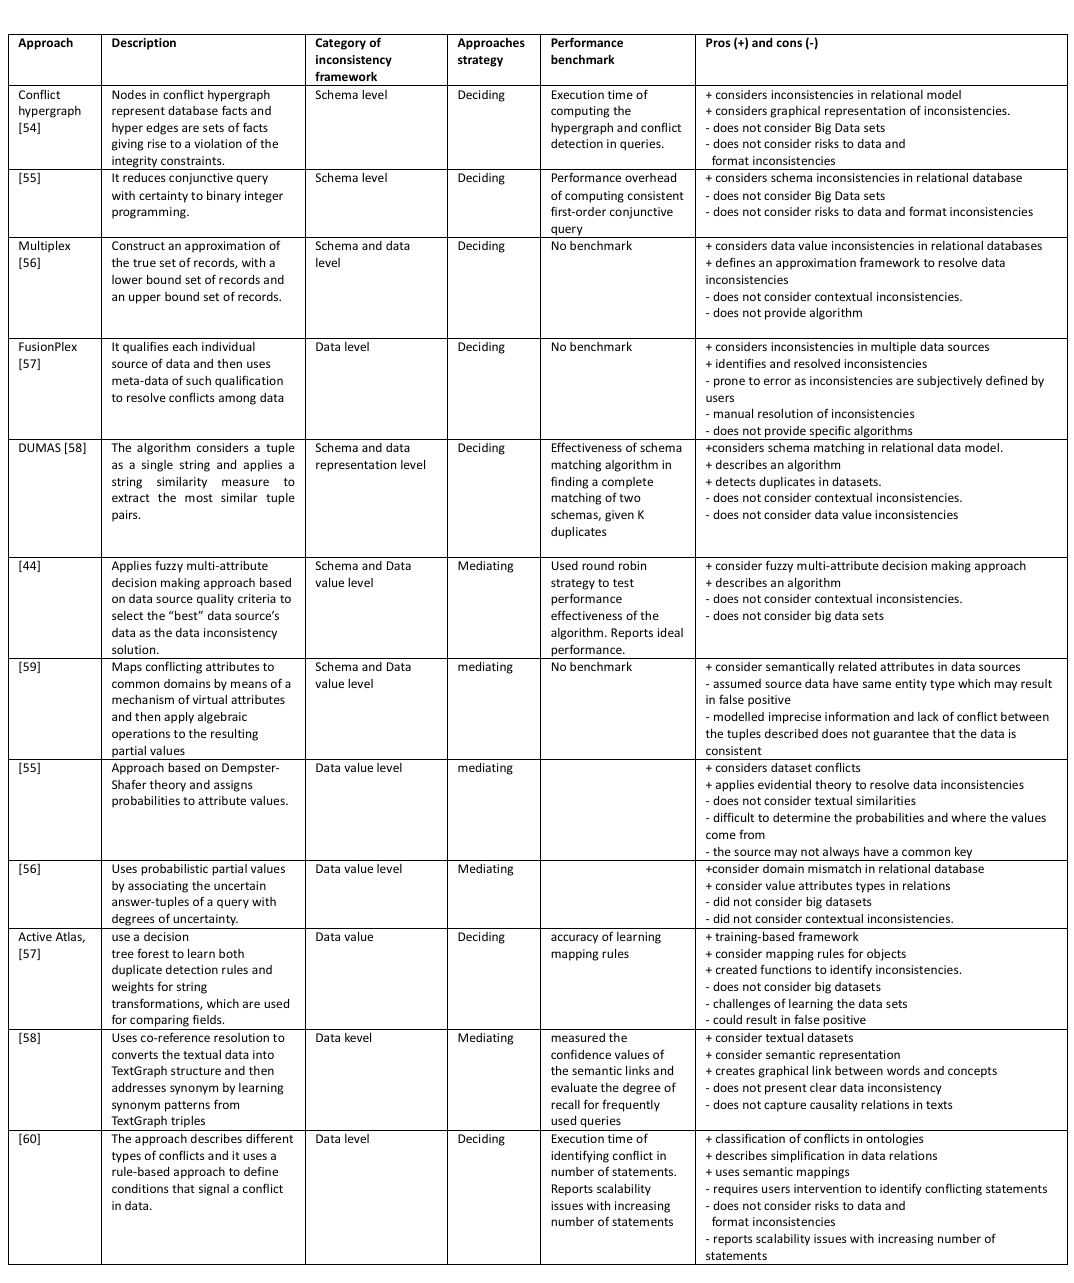
Figure A1. The main approaches to data inconsistency, as discussed in Section 5